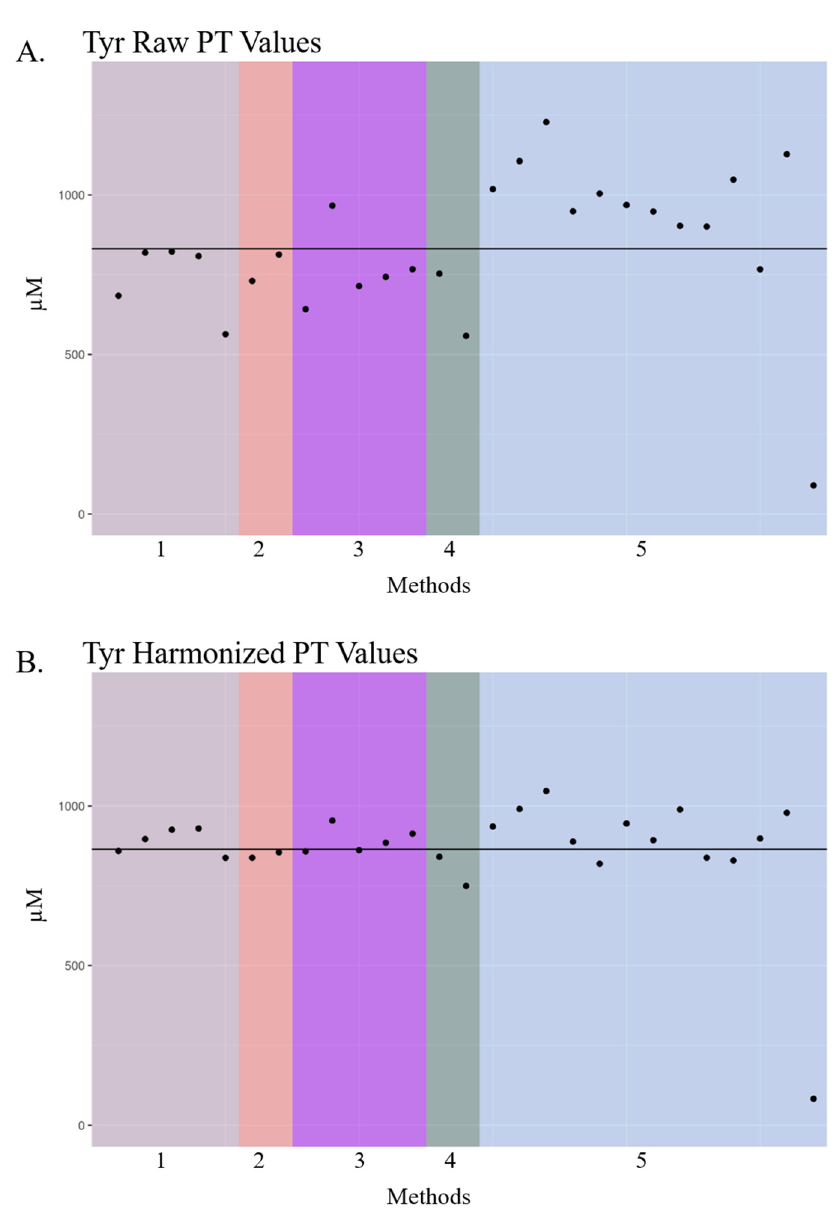
Figure 3. Dot plot of tyrosine proficiency test raw and harmonized data across US public health NBS labs from 2019. Dot plots of raw ( A , B ) harmonized tyrosine (Tyr) proficiency test (PT) data reported by US public health NBS laboratories in 2019. Laboratory names are de-identified. Laboratory PT values are grouped by analytical method, and these unique methods are denoted by color and number. Each “ • ” indicates a unique state laboratory’s PT concentration for Tyr. The black solid line represents the mean of PT values in each plot. Method 1: Derivatized—MS / MS LDT; Method 2: PerkinElmer NeoGram AAAC Tandem Mass Spectrometry kit (Waltham, MA, USA); Method 3: Perkin Elmer Neobase TM 2 Non-derivatized MSMS kit (Waltham, MA, USA); Method 4: Non-derivatized—MS / MS LDT; Method 5: PerkinElmer NeoBase TM Non-derivatized MSMS Kit (Waltham, MA, USA).